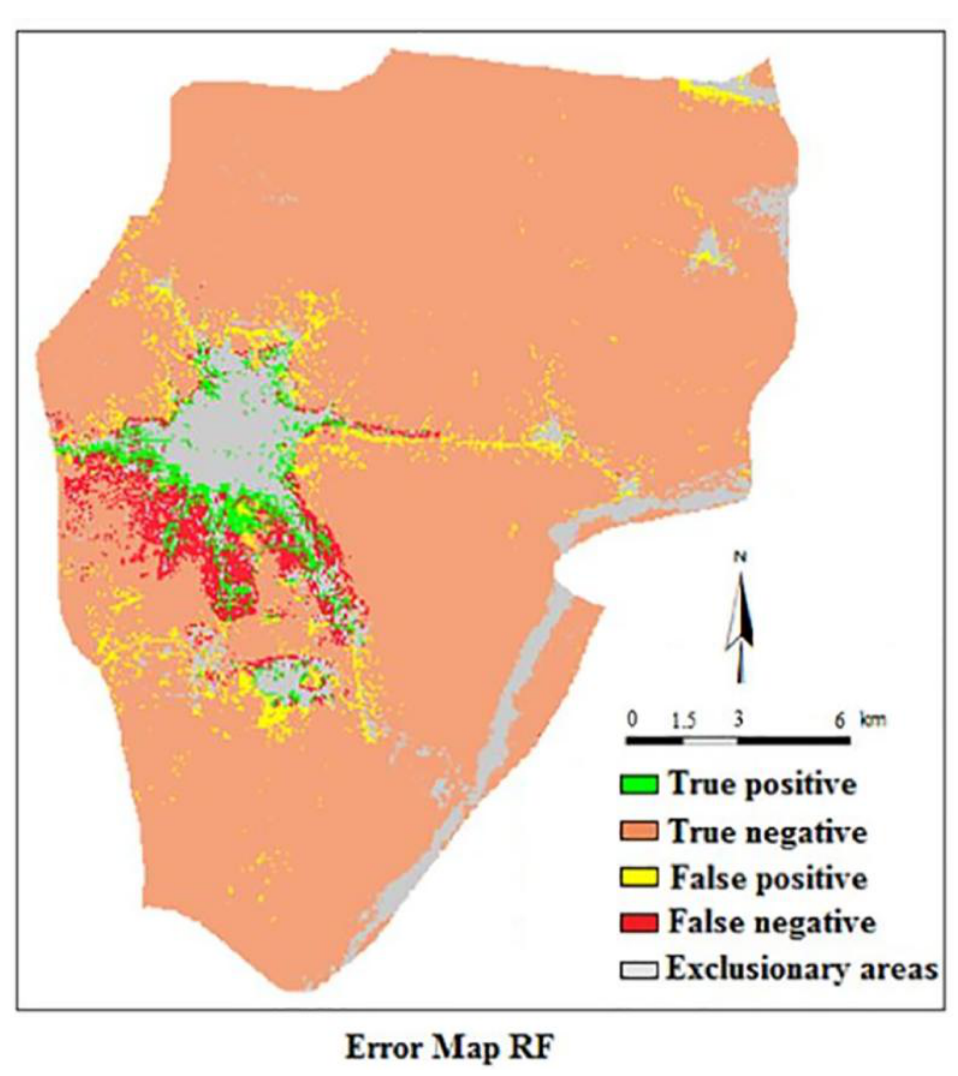
Figure 4 . The observed maps of 2000 and 2015 overlaid by the simulated map of